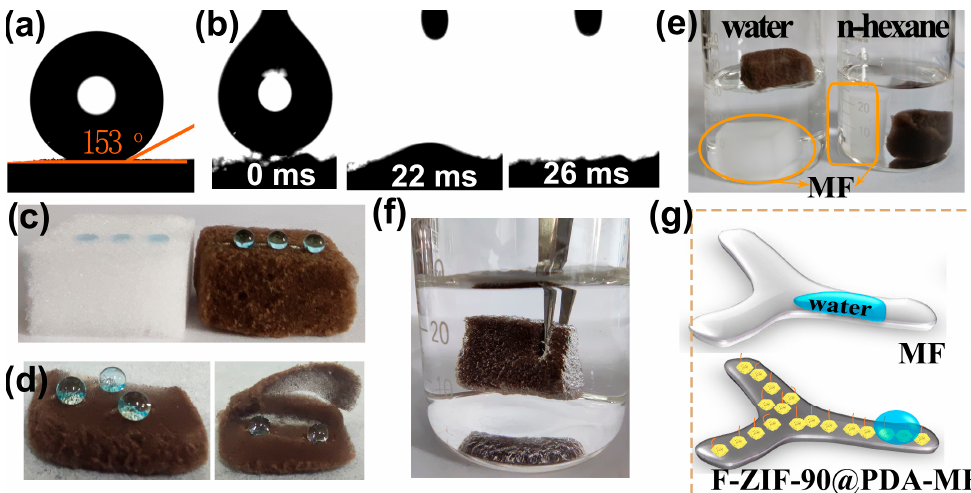
Figure 4. ( a , b ) Contact angle images of a water and oil droplet (n-octane) for the F-ZIF-90@PDA-MF composite sponge. ( c ) Water droplets dyed with methylene blue landed on the pristine MF and composite sponge. ( d ) Photographs of dyed water droplets on different zones of the composite sponge: surface ( left ) and cross-section ( right ). ( e ) Photographs for the di ff erent we tt ability of the raw MF sponge and composite sponge in water and n-hexane. ( f ) An image of the composite sponge soaked in water by an external force. ( g ) Schematic description of superhydrophobicity of the F-ZIF-90@PDA-MF sponge.